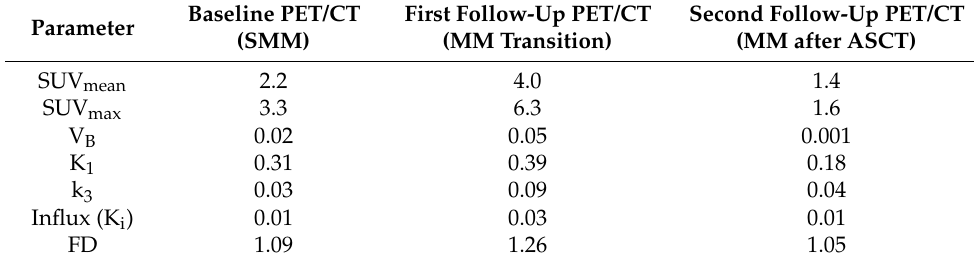
Table 1. Semi-quantitative and quantitative parameters of the bone marrow (iliac bone) derived from dynamic PET/CT at the three time points of scanning. The units of parameters fractional blood volume (V B ), K 1 , k 3 and influx (K i ) are 1/min. SUV mean , SUV max and fractal dimension (FD)